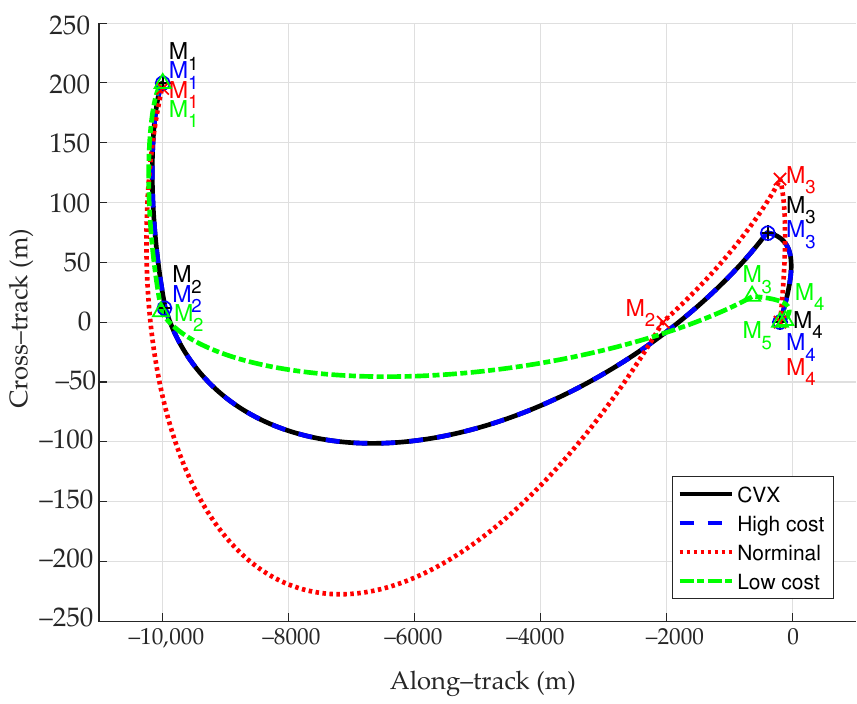
Figure 7. Optimal trajectories (out-of-plane) when t f = 6000